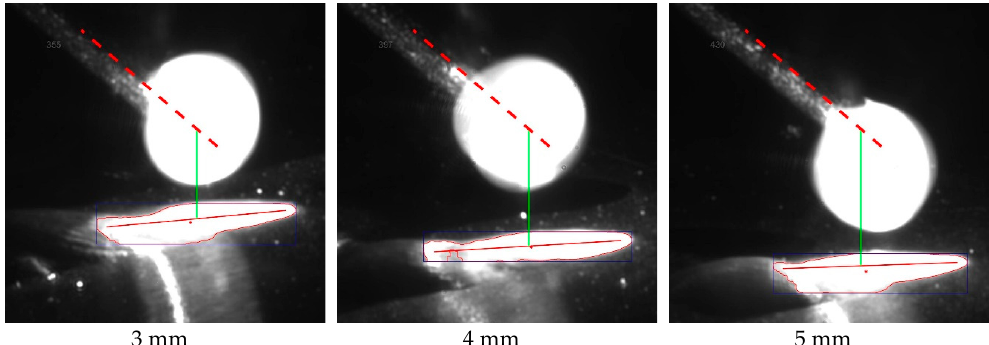
Figure 2. Different droplet transfer states under different droplet transfer distances. Figure 2. Di ff erent droplet transfer states under di ff erent droplet transfer distances.